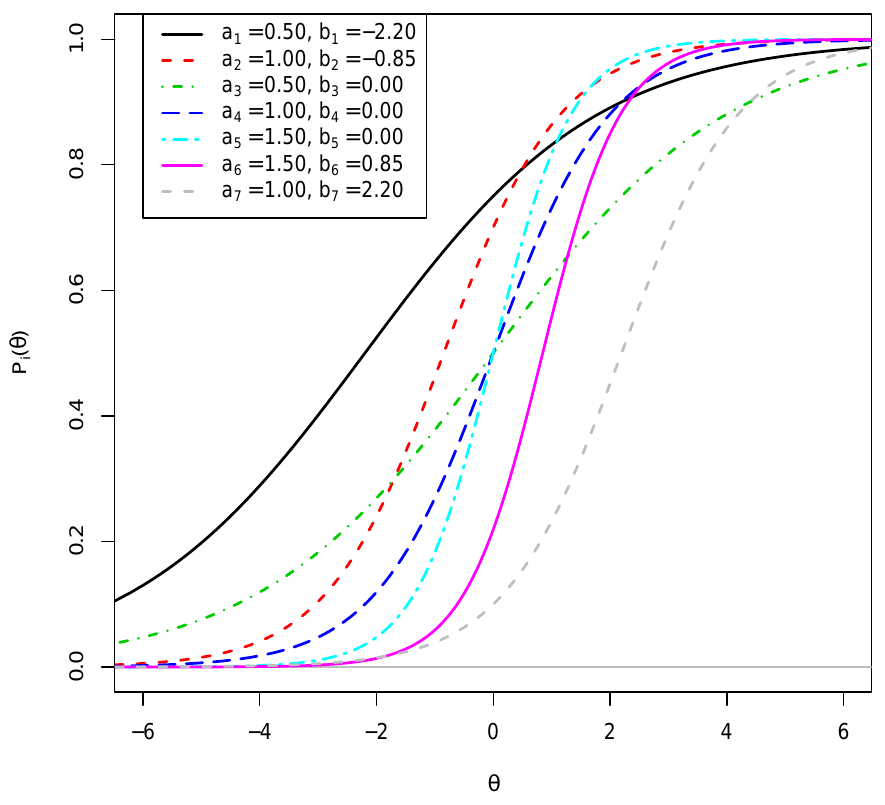
Figure 1. Item response functions for seven items of the 2PL